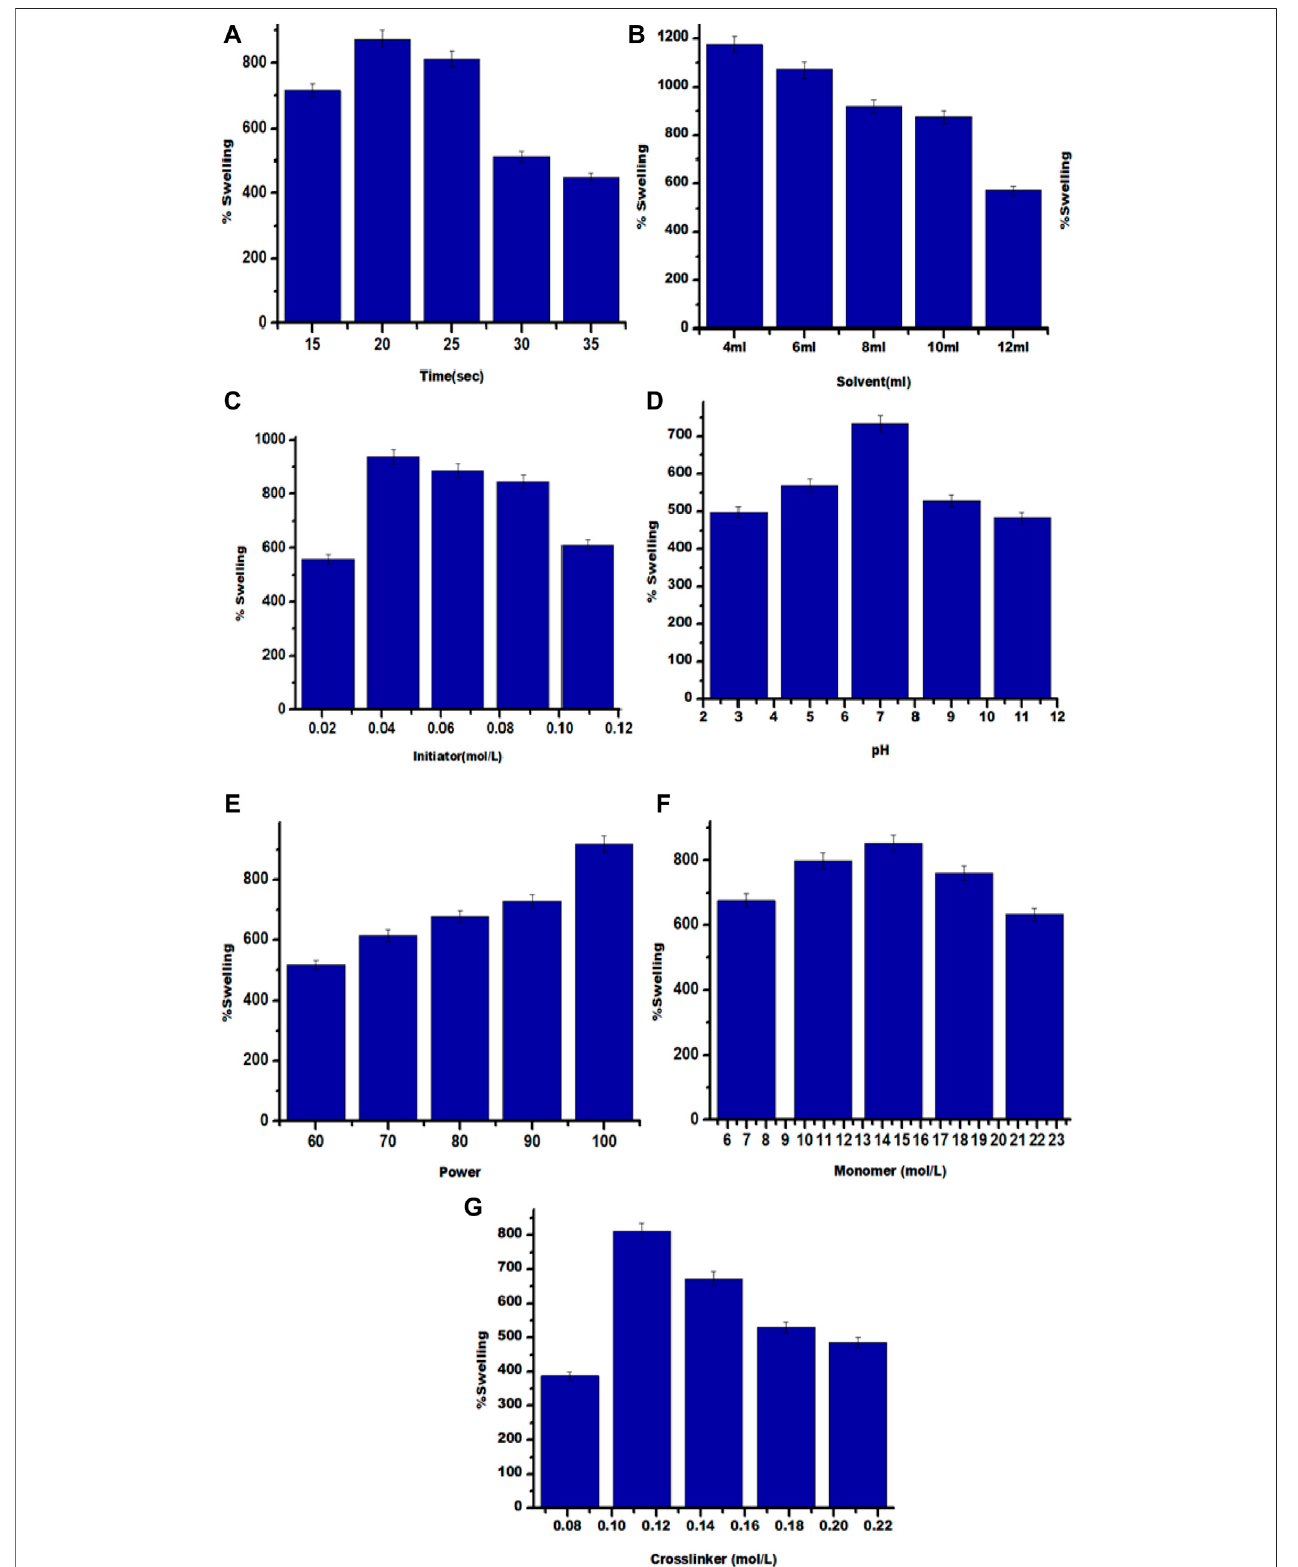
FIGURE 6 | (A-G) Impact of (A) Time; (B) Solvent; (C) Initiator concentration; (D) pH; (E) Power; (F) Monomer concentration; (G) Cross linker concentration on Ps of Kg-cl- poly (AA).